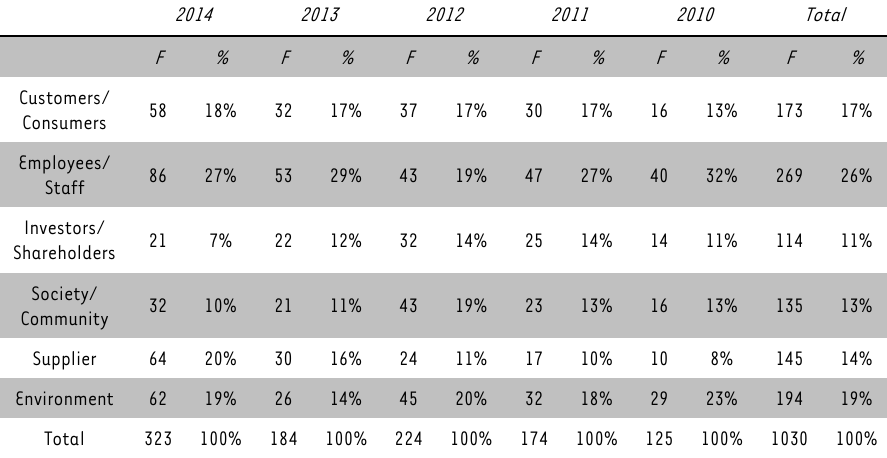
TABLE 1: SPAR stakeholder frequencies from 2010 to